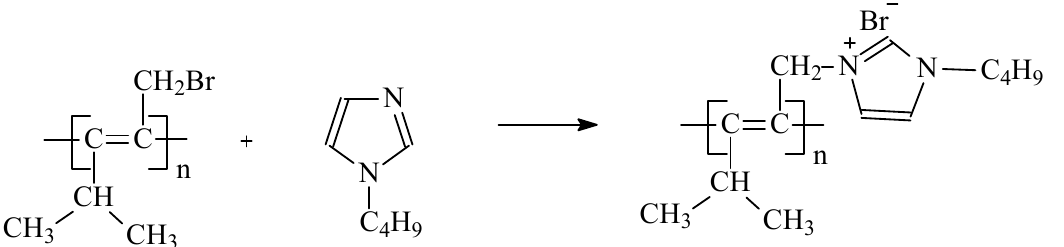
Figure 1. Quaternization of butylimidazolium (BMIm) by brominiated poly(4-methyl-2-pentyne) (PMP-Br).